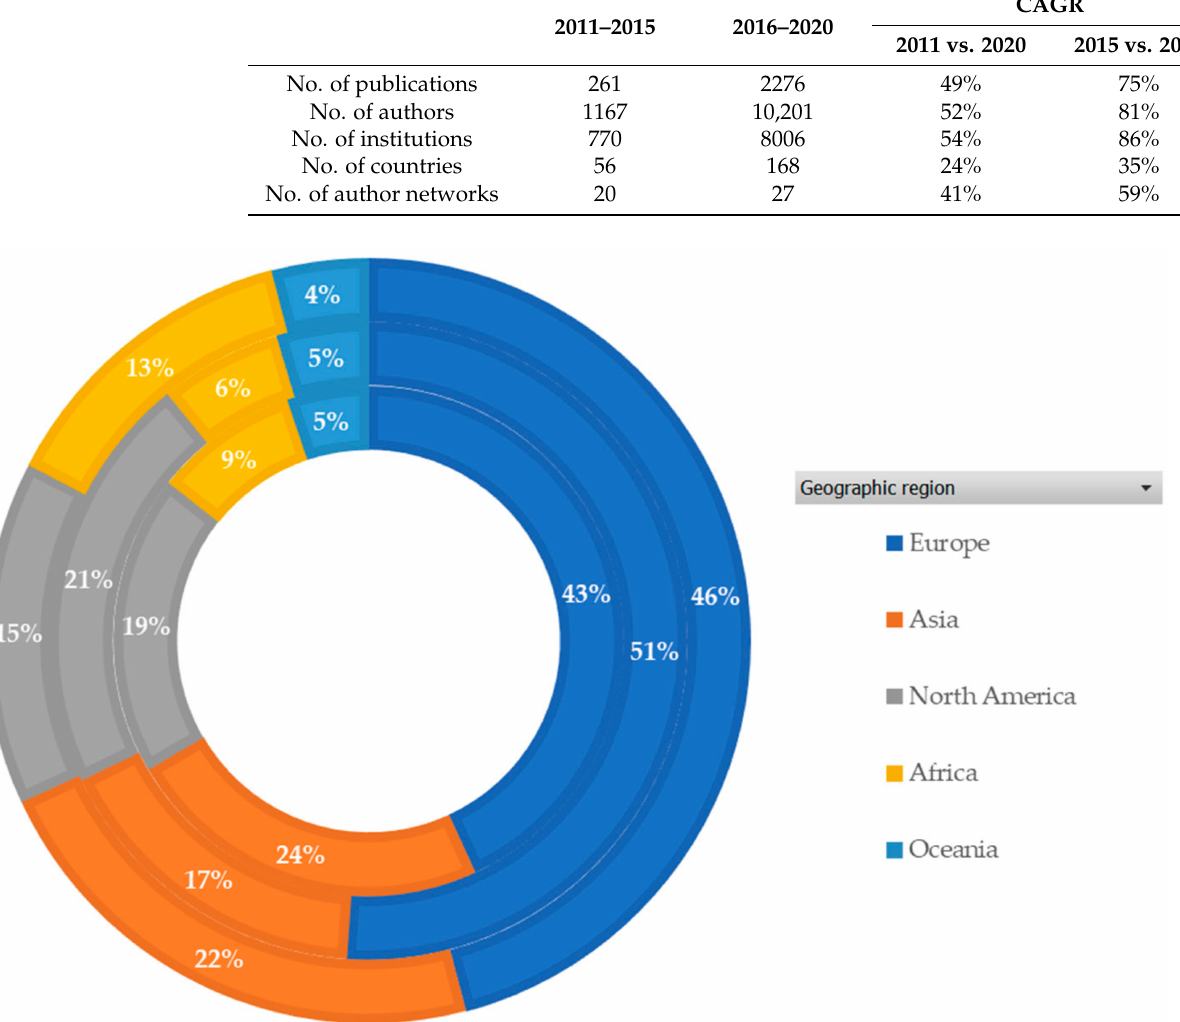
Figure 2. Percentage (%) of publications by geographic region (2011–2020). The inner circle represents the number of AMR- related publications, middle circle represents the citations received for these publications and the outer circle represents the total link strength of these